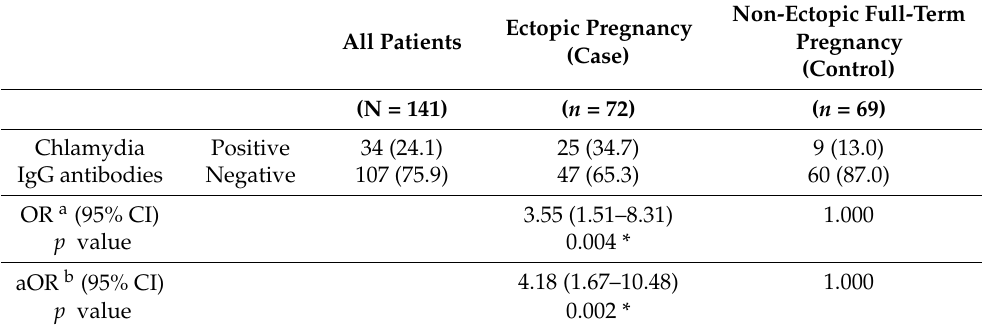
Table 3. Association between chlamydia IgG antibodies and ectopic pregnancies (N = 141).